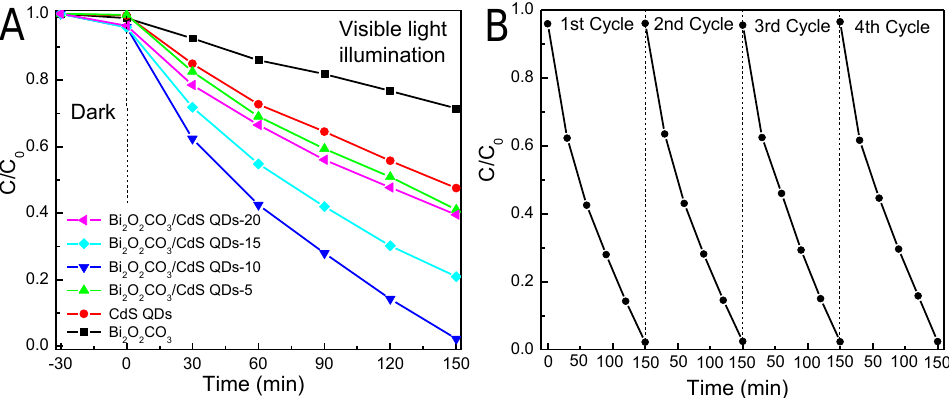
Figure 6. Photocatalytic RhB degradation performance of the prepared photocatalysts ( A ); the cyclic photocatalytic RhB degradation test of Bi 2 O 2 CO 3 /CdS QDs-10 ( B ).